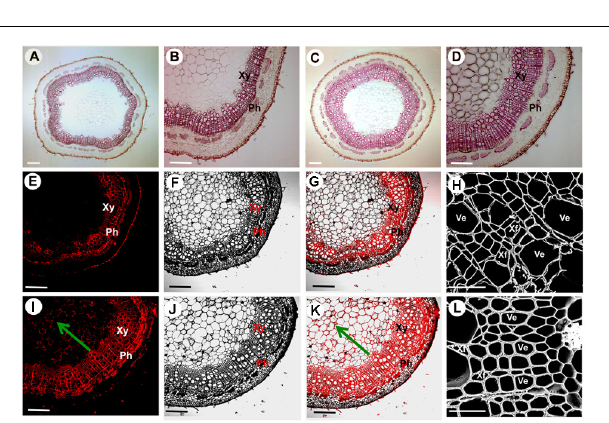
FIGURE 6 | Effects of PtoMYB74 overexpression on secondary cell wall thickening of poplar stems. (A–D) Stem sections from the sixth internode of 10-month-old wild-type and transgenic plants were stained with phloroglucinol-HCl. (E–K) Lignin auto-fluorescence of stem sections at the sixth internode in PtoMYB74 -overexpressing transgenic and wild-type poplar under UV lights were detected by confocal fluorescence microscopy system. (H,L) Scanning electron micrographs of stem cross-sections at the sixth internode in PtoMYB74 -overexpressing transgenic and wild-type poplars. Stem cross-sections used in these images were from the wild type (A,B,E,F,G,H) and transgenic poplars (C,D,I,J,K,L) . Ph, phloem; Xy, xylem; Ve, vessel; Xf, xylary fiber. The green arrow indicates the pith of stems. Scale bars: A,C = 500 µ m; B,D,E,F,G,I,J,K = 200 µ m; H,L = 10 µ m.